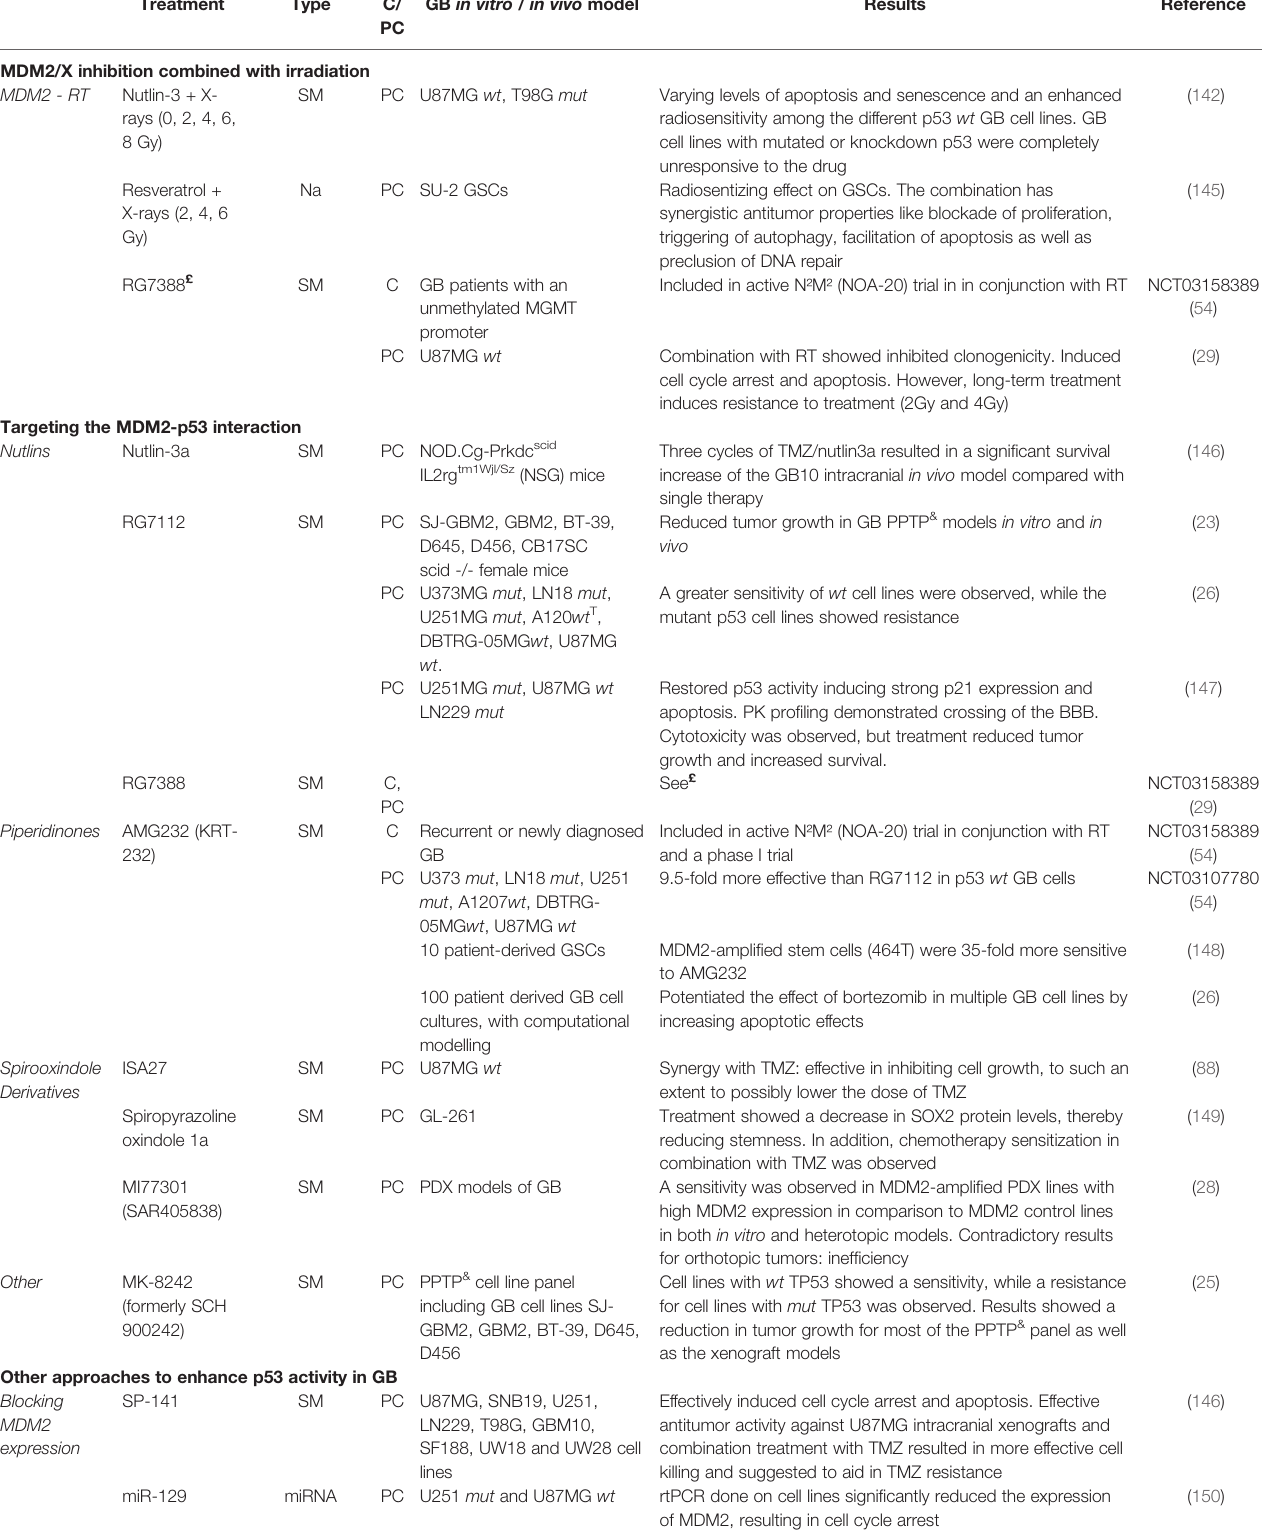
TABLE 1 | Overview of single or combined GB treatment strategies with MDM2/X inhibitors.